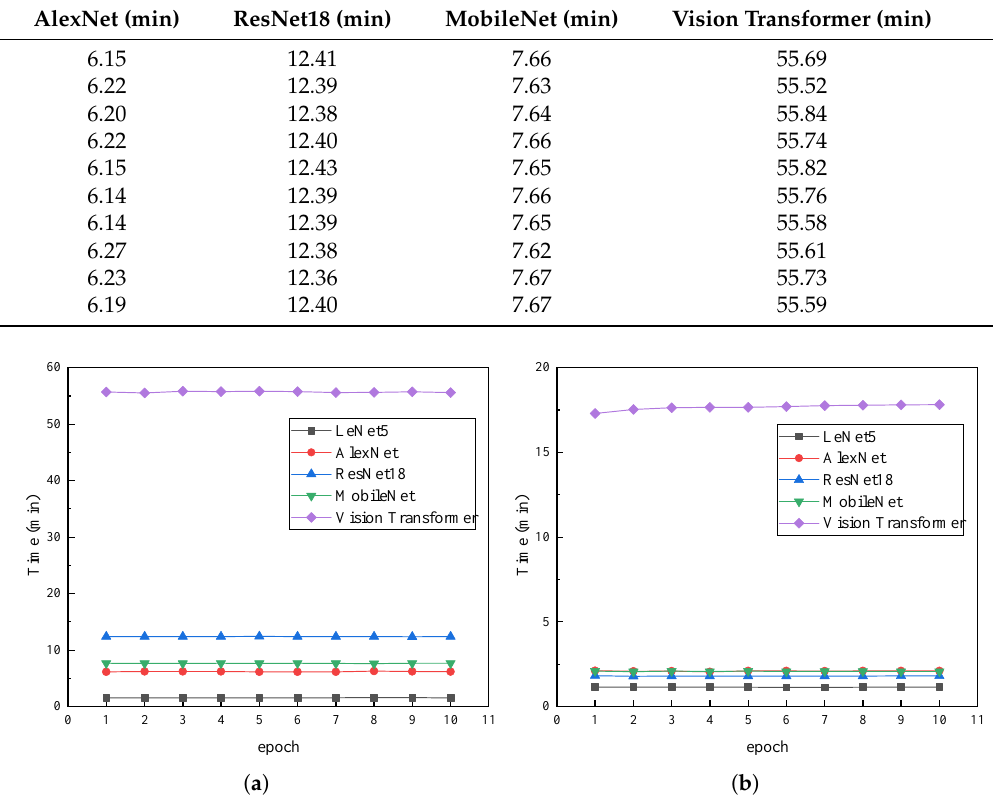
Figure 10. Comparison of the efficiency after data augmentation. ( a ) Comparison of the efficiency of each model after data augmentation and before GPU loading. ( b ) Comparison of the efficiency of each model after data augmentation and after GPU loading. Table 12. Computational efficiency of per epoch operation for each model after data augmentation and after GPU